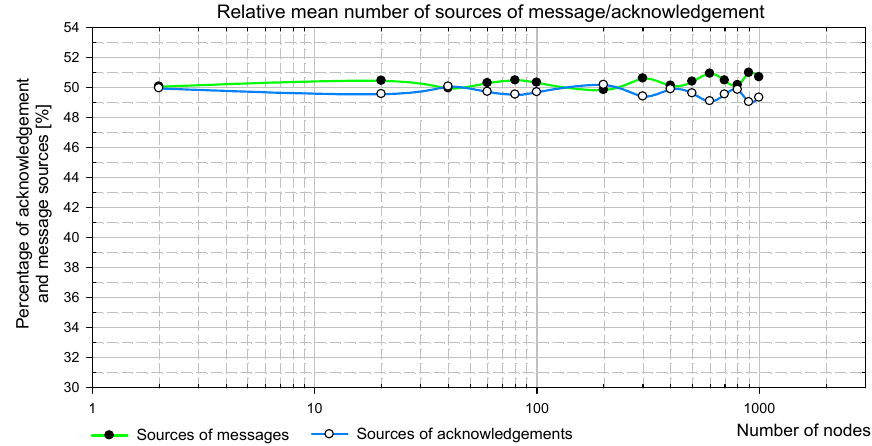
Figure 9. Simulation results of the mean number of message/acknowledgement sources in the saturation network steady state